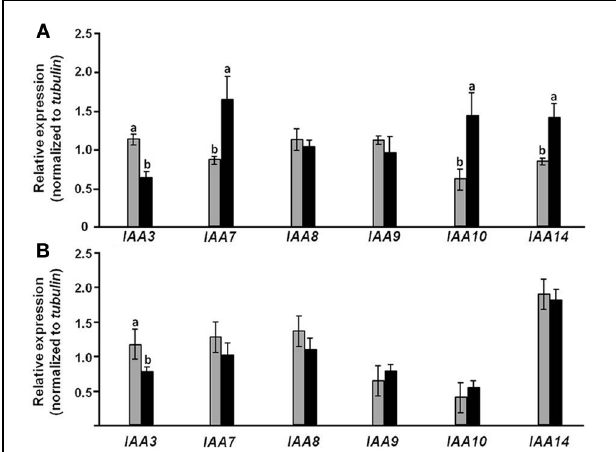
FIGURE 8 | Effect of CmF-308 expression in the phloem of tomato plants on the expression of auxin-response genes. Expression of members of the Aux/IAA gene family was determined by qRT-PCR in leaves (A) and roots (B) of 21-day-old CmF-308 -transgenic (gray columns) and control M-82 (black columns) plants. Data represent means of four replications ± SE. Different letters indicate significant differences in relative expression of specific genes between the two plant lines at p < 0 . 05 by Student’s t -test.